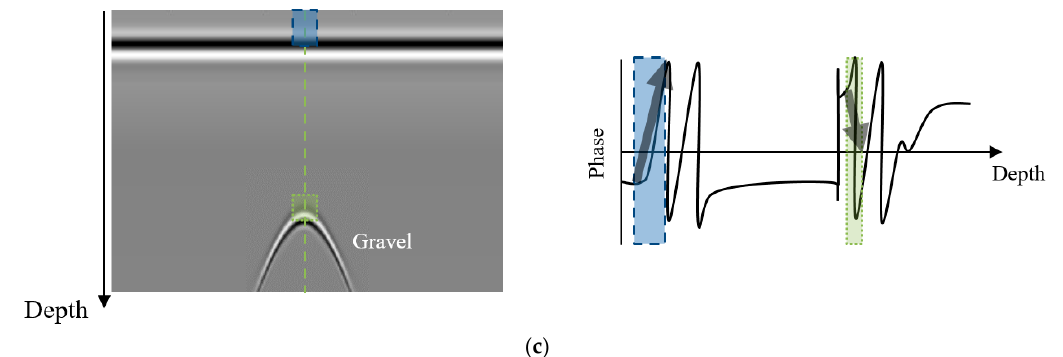
Figure 7. Numerical simulation of phase analysis: ( a ) 2D simulation model, ( b ) cavity case, and ( c ) gravel case. The dashed blue box, line red box, and dotted green box in the B-scan images correspond to the locations of the radiated wave, cavity, and gravel boundaries, respectively. (Tx: Transmitter antenna, Rx: Receiver antenna).